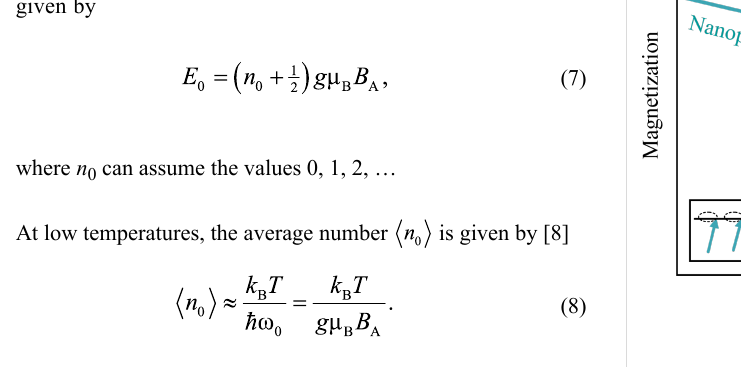
Figure 2: Schematic illustration of spin waves in macroscopic crystals (red arrows) and uniform excitations in nanoparticles (blue arrows) and the corresponding temperature dependence of the magnetization. T B is the superparamagnetic blocking temperature and T C is the Curie